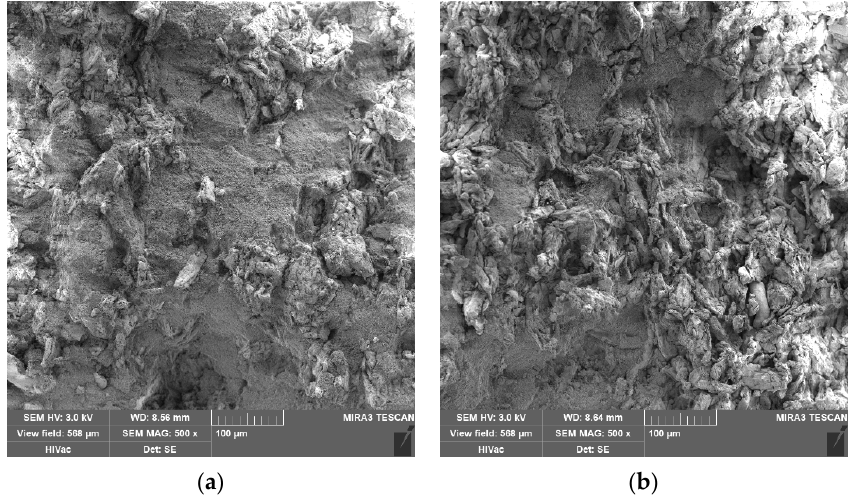
Figure 4. Images of PrunusP_E_HA_180 min ( a ) and PrunusP_E_MW_3 min ( b ).